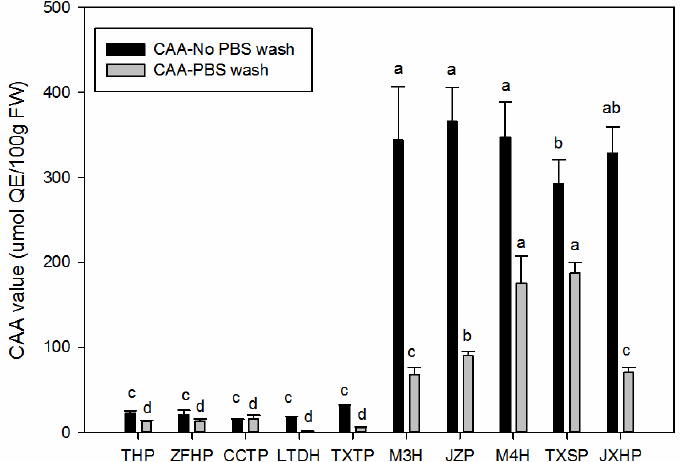
Figure 5. The cellular activities of the five sweet and five sour wampee varieties obtained by the ORAC assay. Bars with no letters in common are significantly different ( p < 0.05).